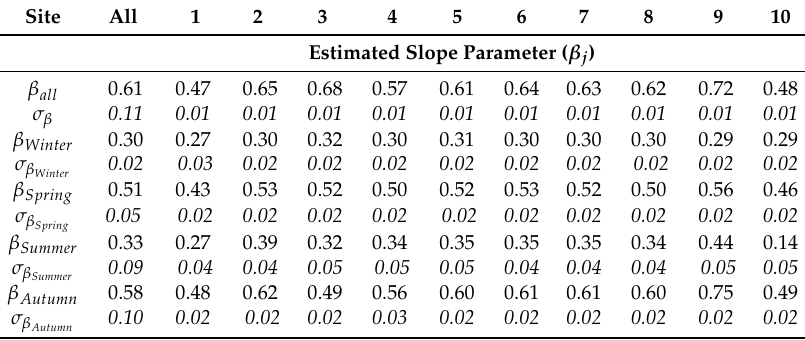
Table 4. Estimated slope parameter ( β j ) at each site j standard deviation (italics), and estimated β j for each site for the given season and standard deviation